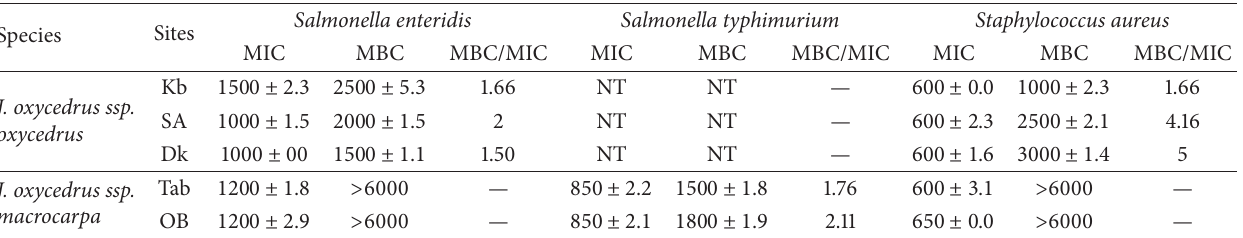
Table 4: Minimum inhibitory concentration (MIC) ( 𝜇 g/mL) of J. oxycedrus ssp. macrocarpa and J. oxycedrus ssp. oxycedrus essential oils against bacterial strains ∗